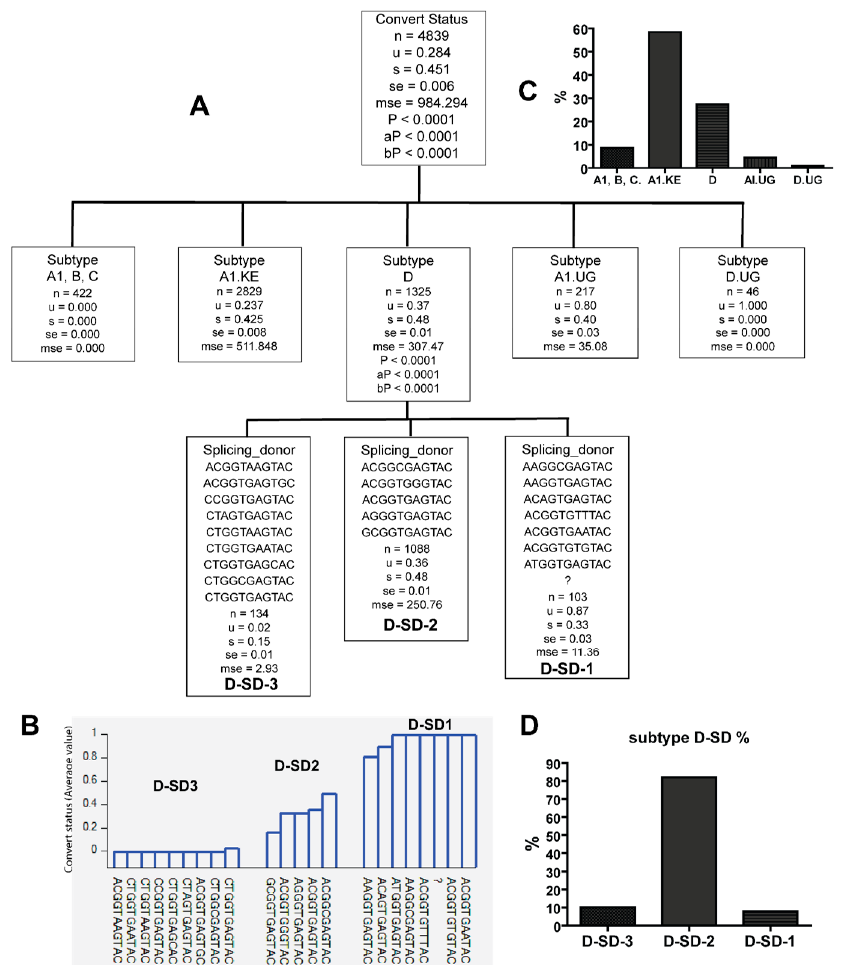
Figure 8. The combination of HIV subtype D and splicing donor sequences (SD) identified only in either late ( u = 1) or early seroconverters ( u = 0). ( A ) HIV subtype D in tree node of subtype D was further classified with SD sequence variants based on whether they were identified from late ( u = 1) or early seroconverters ( u = 0); ( B ) the figure shows u value of sequence combinations based on whether the subtype D–SD combinations were identified from late (1) or early (0) seroconverters. Note: n— counts (clone); u— mean value; s—standard deviation; se—standard error; mse—mean